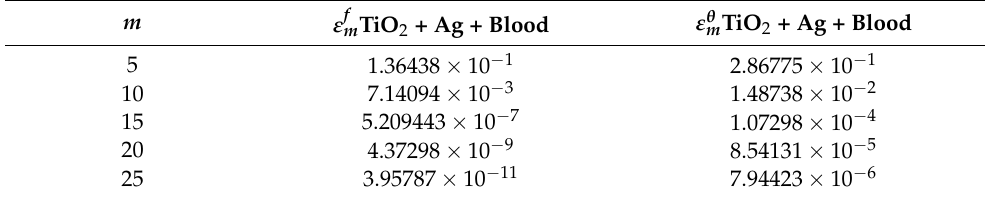
Table 3. Convergence of the method for TiO 2 + Ag + Blood when Pr = 6, M = 10, Ec = 1, k ∗ = 1, λ = 1.